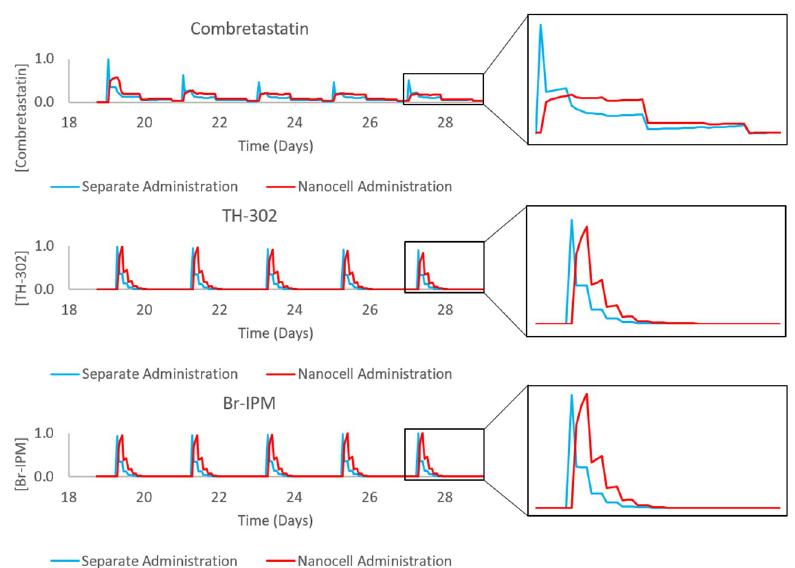
Fig 8. Normalized drug concentrations in the tumour area over the treatment schedule for combretastatin-first treatment administered either separately or through nanocells. The left column of plots is the full treatment schedule used in simulations, the right column is a zoomed-in picture of the final drug administration to better observe the difference in release profiles. Notice the delayed release in the nanocell administration case.